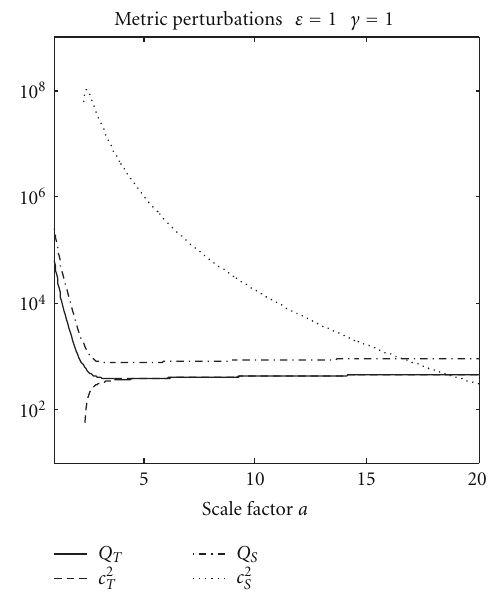
Figure 9: Evolution of Q T , Q ϕ , and c 2 two speeds are negative in the early